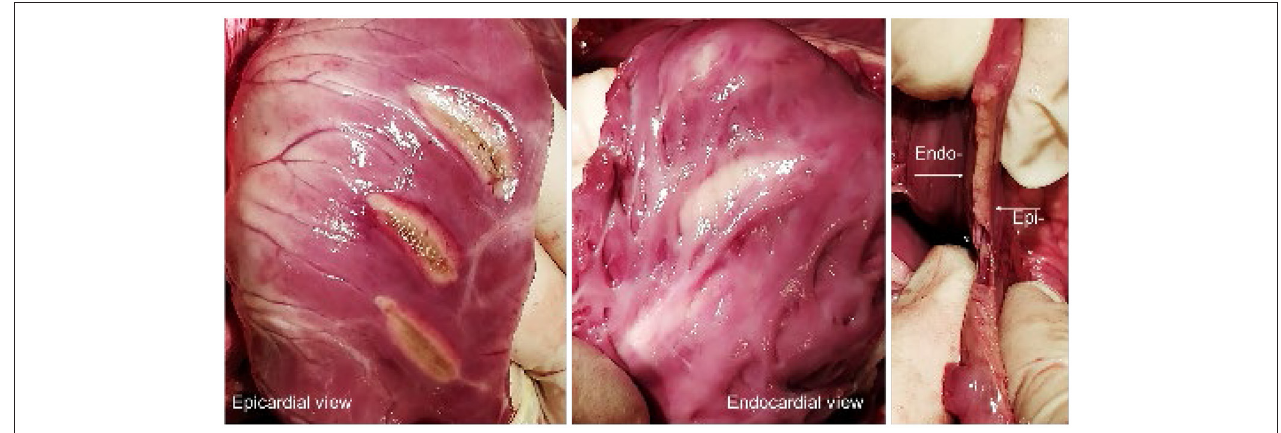
FIGURE 4 | (Left, Middle) Epi- and endocardial view of three epicardial RV ablations. (Right) Axial section of a lesion, displaying the transmurality and linearity.